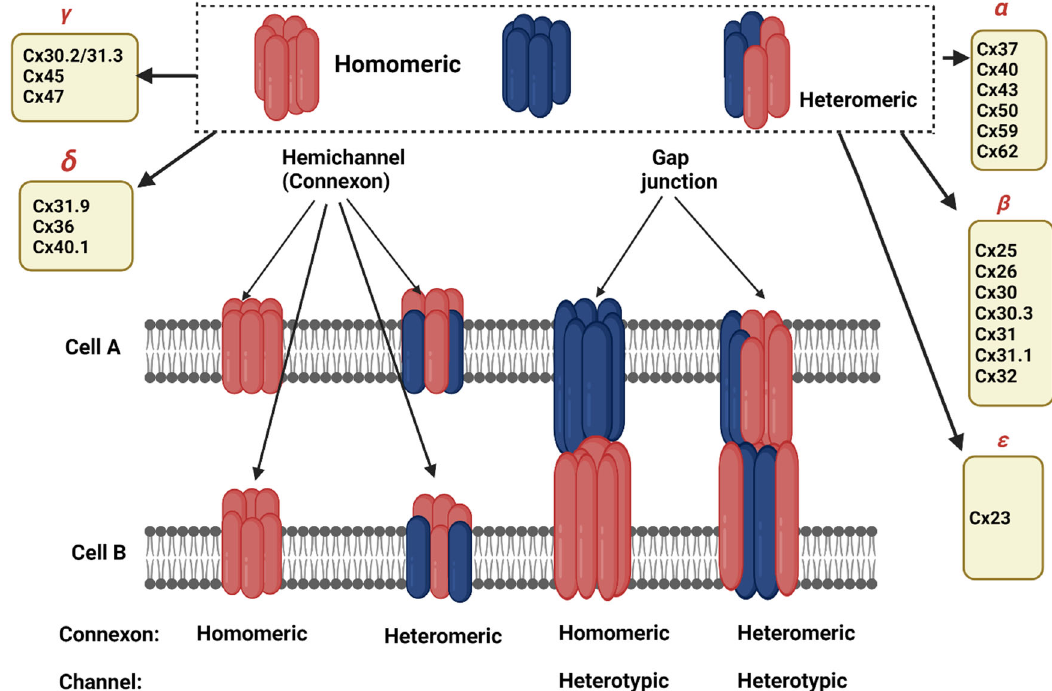
Fig. 6 Pictorial depiction showing that connexins can be arranged in many different ways in a gap-junction channel. The diagram depicts several constituents of the gap-junction channel. A particular kind of connexin forms homomeric connexons. Heteromeric connexons are made up of greater than a single connexin kind. Whenever connexons of a similar structure create a gap-junction channel, it is referred to be a homotypic channel. Whenever the constituents of the connexons vary, the channels are known as heterotypic. Depending on homology, the connexin group is classi fi ed into fi ve subgroups ( α , β , γ , δ , and ε ) 211 . Connexins oligomerize into homomeric or heteromeric hexamers alongside adjacent connexins of a similar subtype as well as on rare occasions, with connexins of different subtypes, resulting in a very diverse channel con fi gurations 211